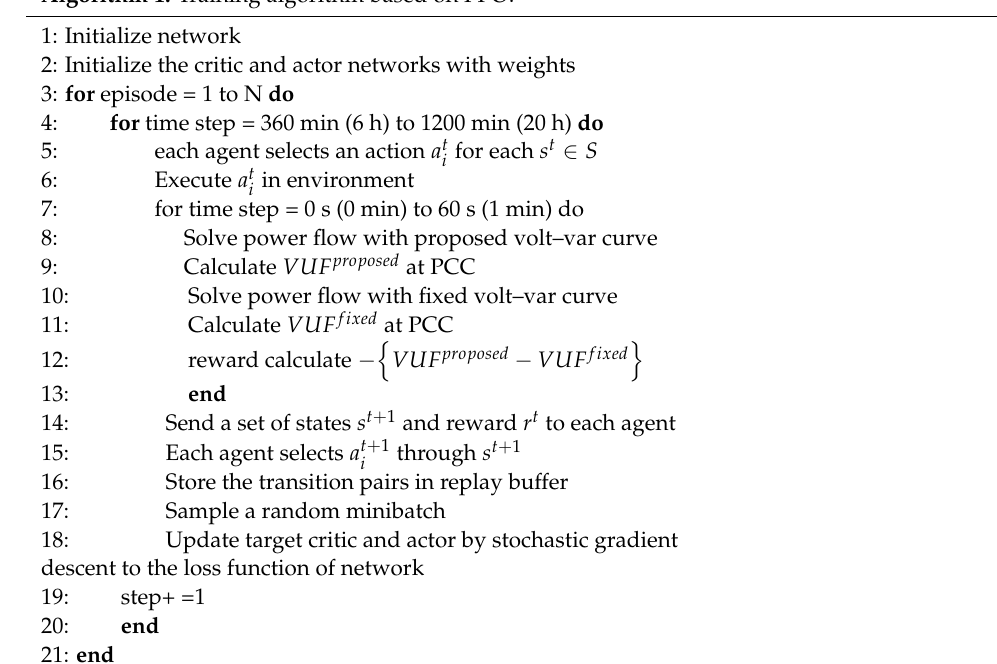
Algorithm 1. Training algorithm based on